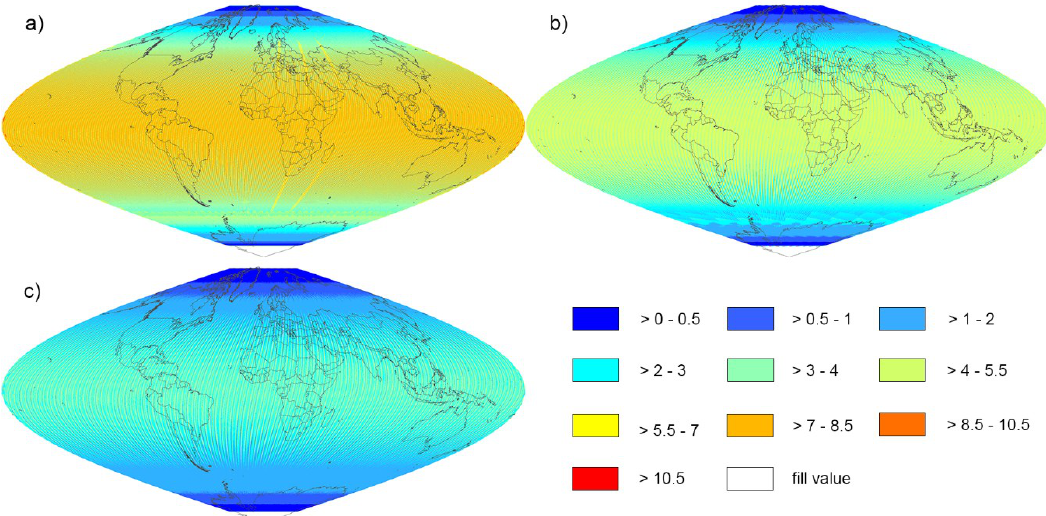
Figure 1. Global average revisit interval (days) maps for the combinations of ( a ) Landsat‐8 and Landsat‐9, ( b ) Sentinel‐2A and Sentinel‐2B, and ( c ) Landsat‐8, Landsat‐9, Sentinel‐2A and Sentinel‐2B from 1 January to 31 December 2016. The results were examined on a global grid, defined by an equal area sinusoidal projection, composed of 7201 × 3601 grid points, with a spacing of 0.05°. Country boundaries using a sinusoidal projection were overlapped on the maps.